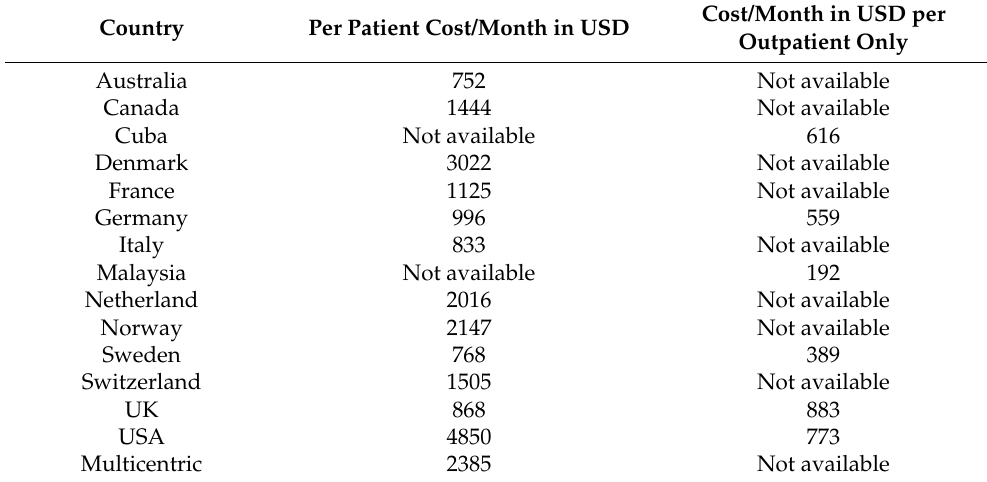
Table 1. Stroke services monthly cost/patient for the year 2015